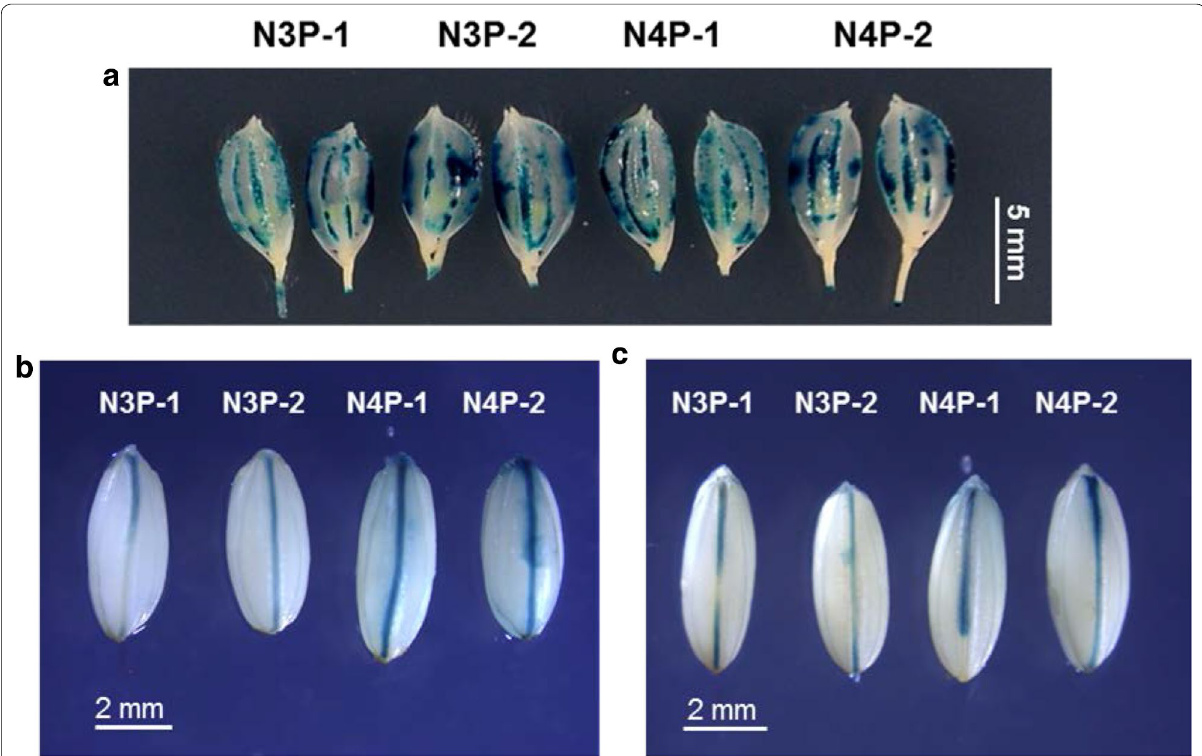
Fig. 9 Tissue‑specific expression of OsNCED3 and OsNCED4 in the husks and seeds of transgenic rice plants. a GUS staining in husks of OsNCED3 :: GUS (N3P) and OsNCED4 :: GUS (N4P) transgenic rice plants. b GUS staining in dry seeds of N3P and N4P transgenic rice plants. c GUS stain‑ ing in imbibed seeds of N3P and N4P transgenic rice plants. In a , the husks were harvested at heading stage. In c , the seeds were imbibed in water at 25 °C for 24